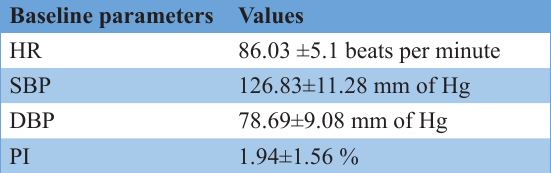
Table 1. Baseline haemodynamic variables. Baseline parameters Values